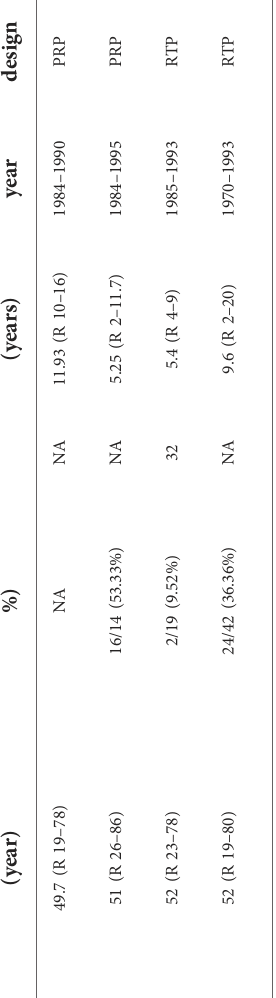
Figure S5 ). Subgroup analysis according to follow-up time was not signi fi cantly different between subgroups ( P >